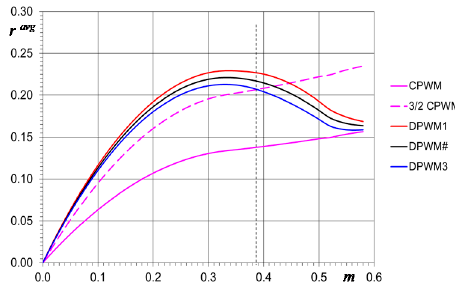
Figure 19. Average of the normalized peak ‐ to ‐ peak current ripple as the function of modulation index for different modulation techniques.